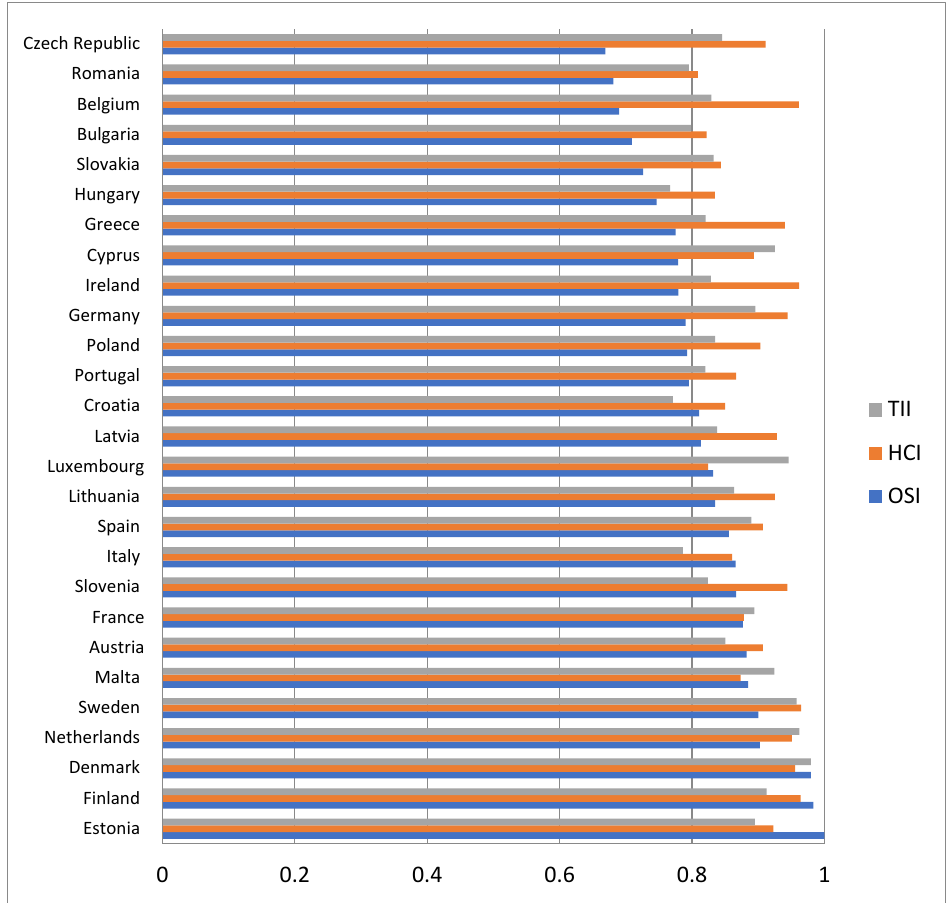
Figure 4. Evolution of EGDI dimensions in the European Union member states.